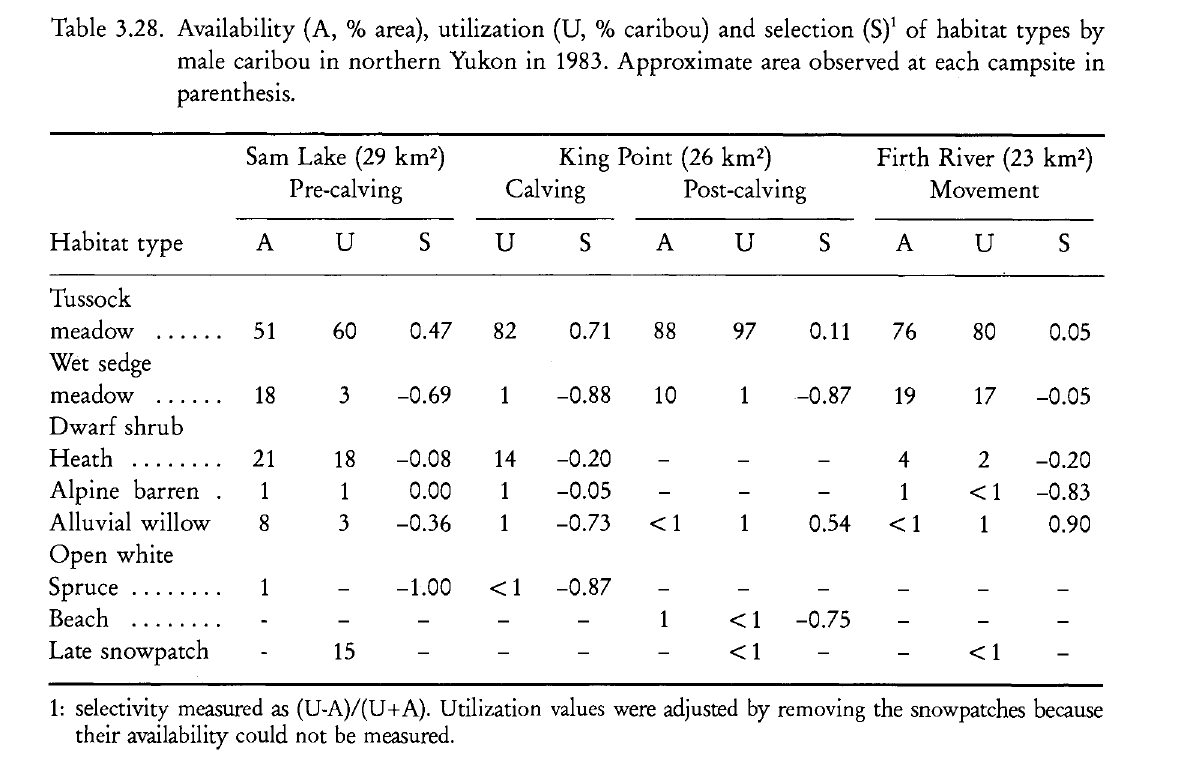
Table 3.28. Availability (A, % area), utilization (U, % caribou) and selection (S) 1 of habitat types by male caribou in northern Yukon in 1983. Approximate area observed at each campsite in